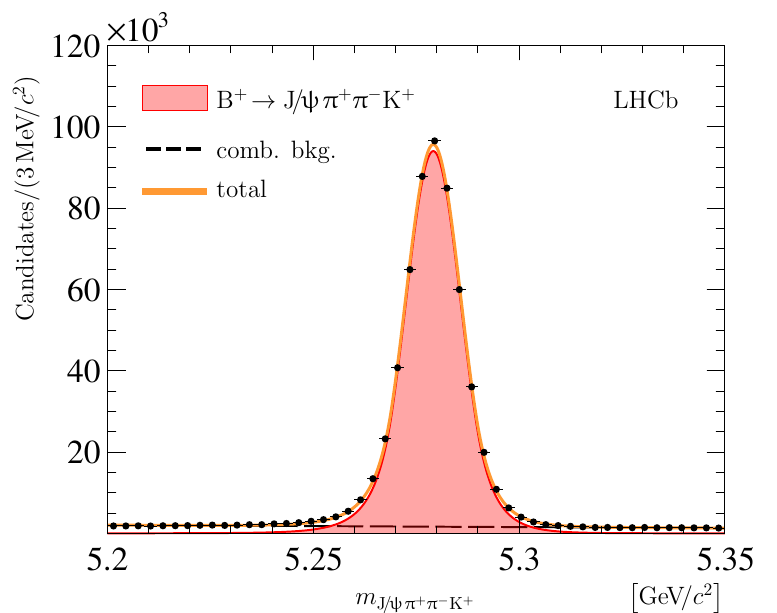
Figure 1 . Distribution for the J = (cid:25) + (cid:25) (cid:0) K + mass for selected B + candidates (points with error bars). A (cid:12)t, described in the text, is